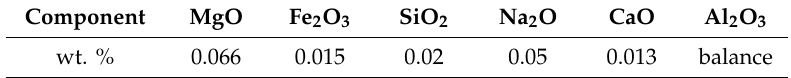
Table 1. Chemical composition of Al 2 O 3